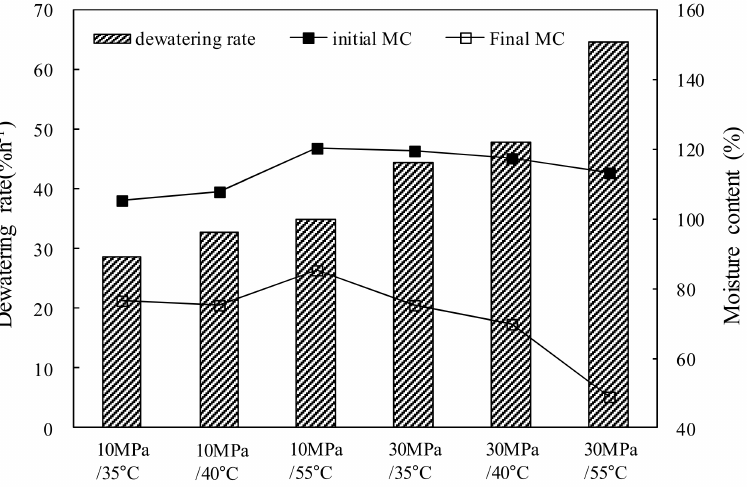
Figure 4. Effects of pressure and temperature on dewatering